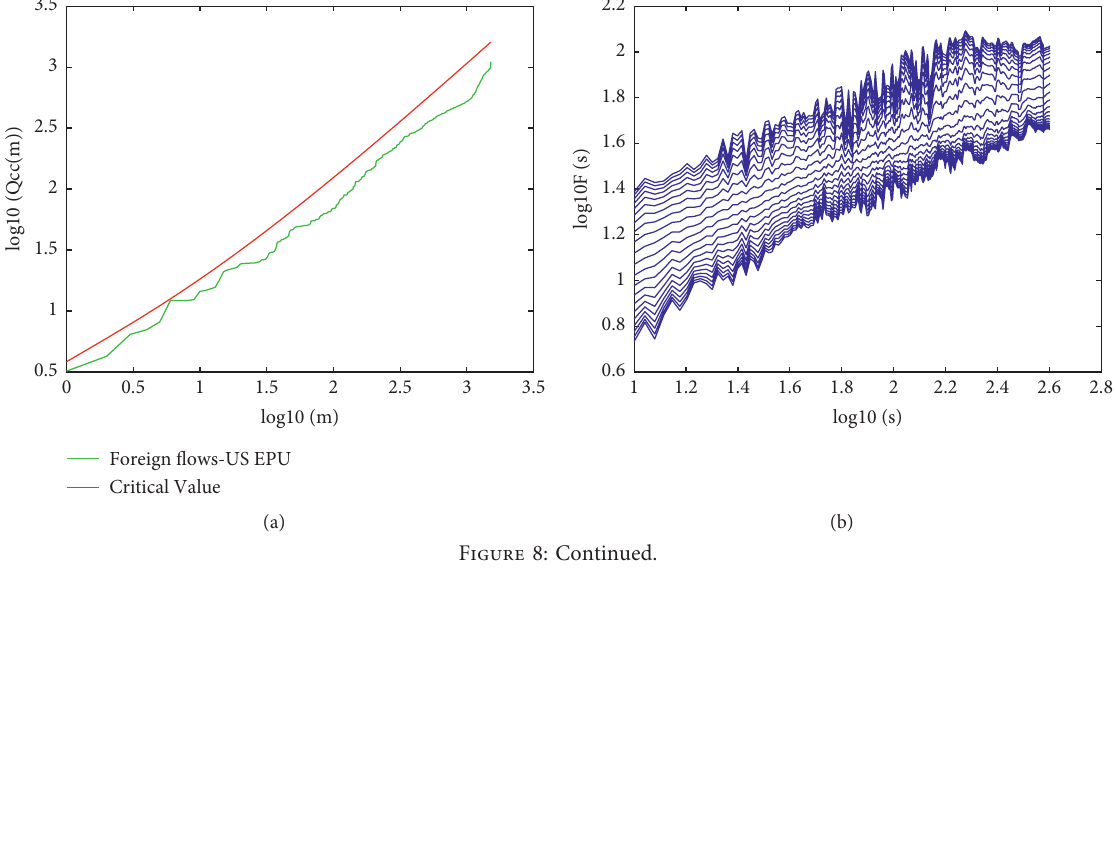
Figure 7: Cross-correlation analysis and MF-DCCA analysis between HGTand VIX index. (a) Cross-correlation statistics Q log plots of F q ( s ) versus s . (c) Generalized Hurst exponent of H ( q ) versus q . (d) Renyi exponent of τ ( q ) versus q . (e) Multifractal spectrum f ( α ) versus α